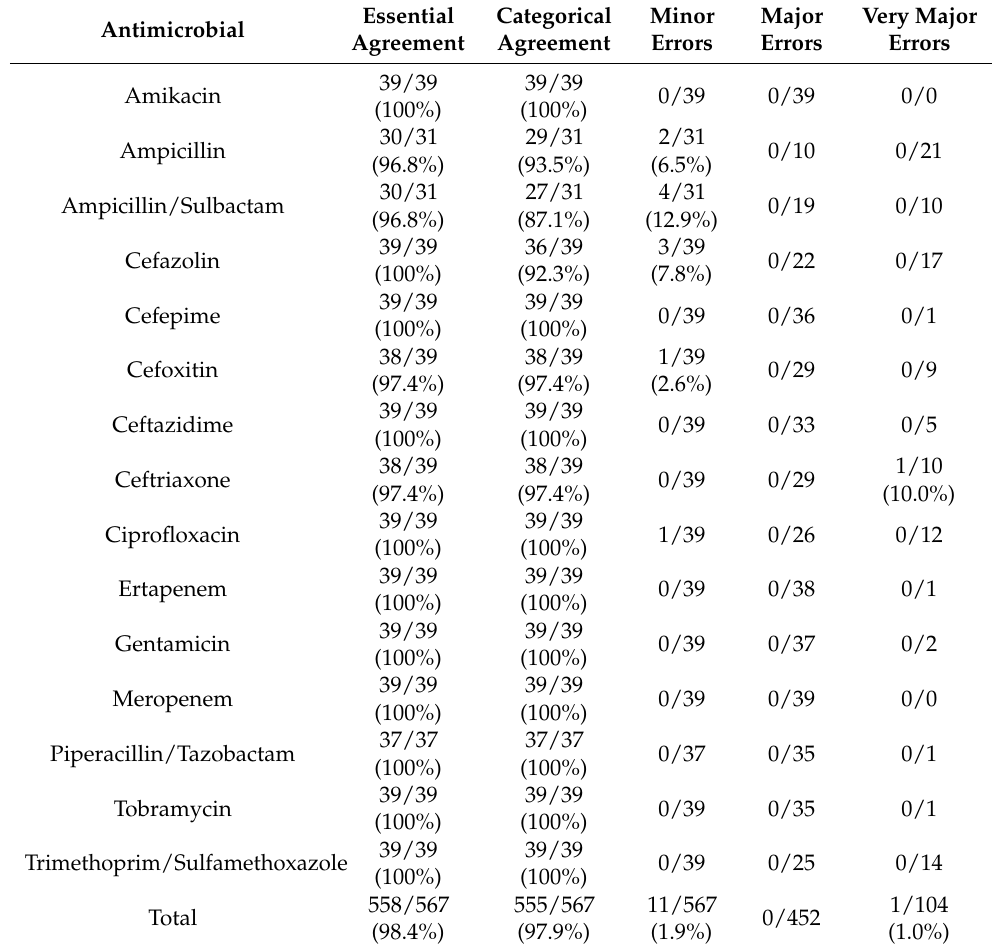
Table 4. Comparison of AST results of LC vs. standard workflow: subgroup analysis for specimens containing Enterobacterales